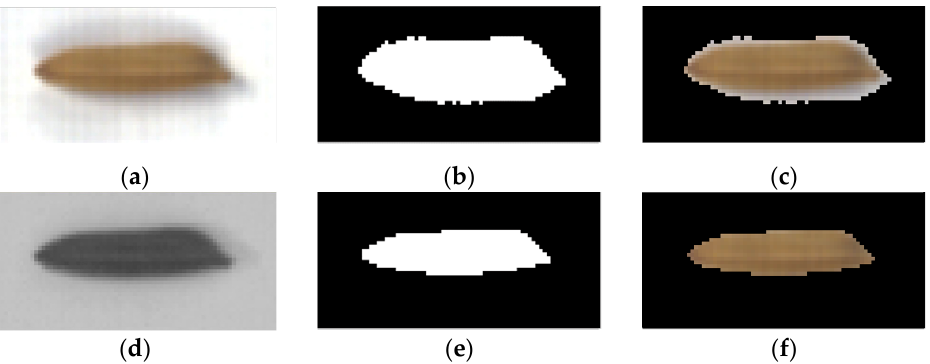
Figure 4. Example of background segmentation using synthesised spectral slope greyscale image. ( a ) Colour image of a seed; ( b ) Binarised image using single-band (601.55 nm) information; ( c ) Segmentation result using single-band (601.55 nm) information; ( d ) Synthesised spectral slope greyscale image; ( e ) Binarised image using spectral slope information; ( f ) Segmentation result using spectral slope information.